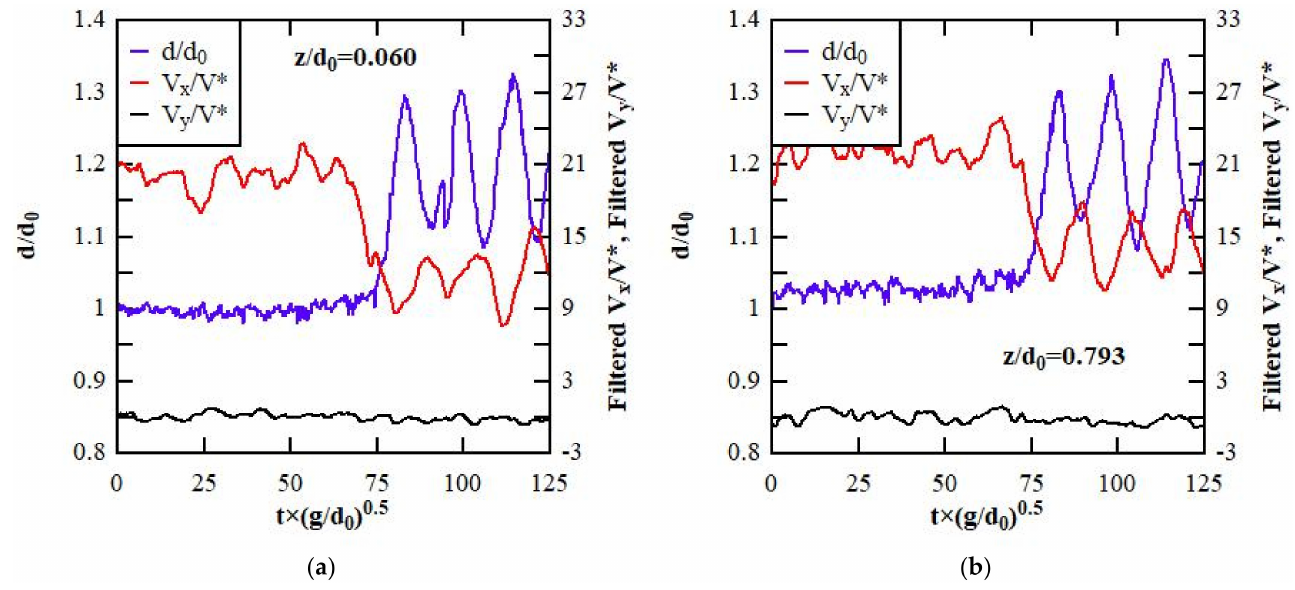
Figure 4. Undular surge, Run 60-7. Dimensionless instantaneous water depth d / d 0 and velocity components V x / V * and V y / V * at ( a ) z/d 0 = 0.060; ( b ) at z/d 0 = 0.793 (redrawn from [17]).